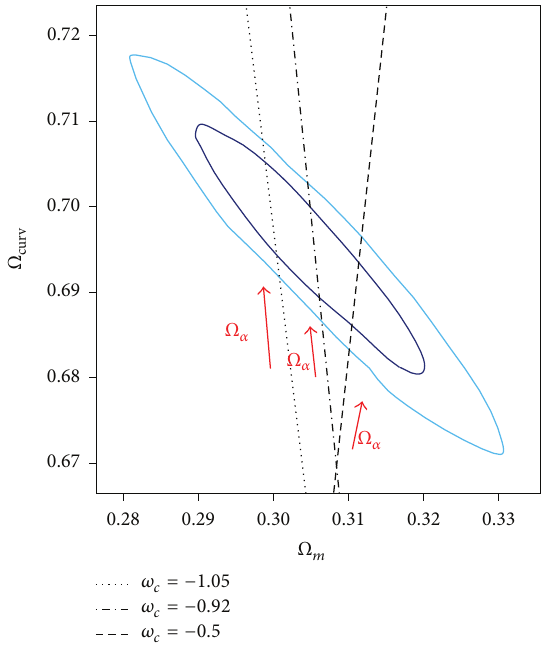
Figure 8: Ω versus Ω 𝑚 in the background of Planck + WMAP + curv high L+ lensing + BAO joint data.